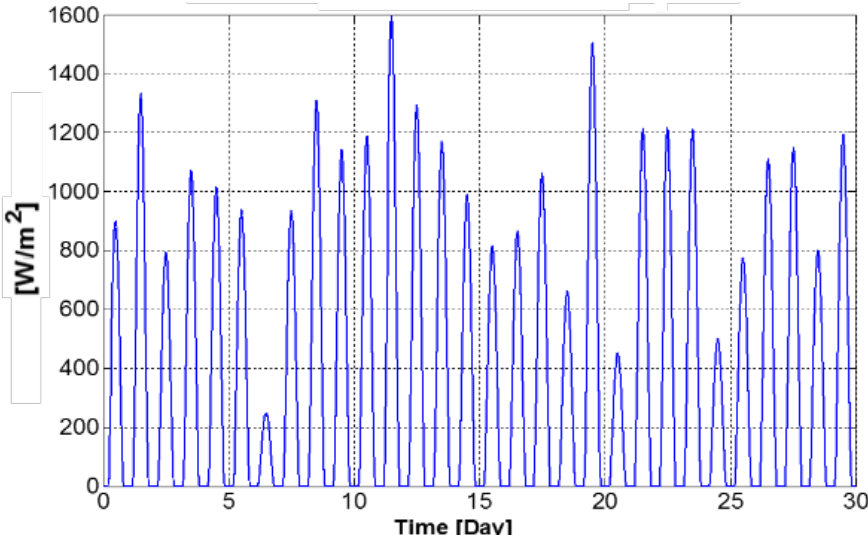
Figure 13. Modelization results: solar radiation.